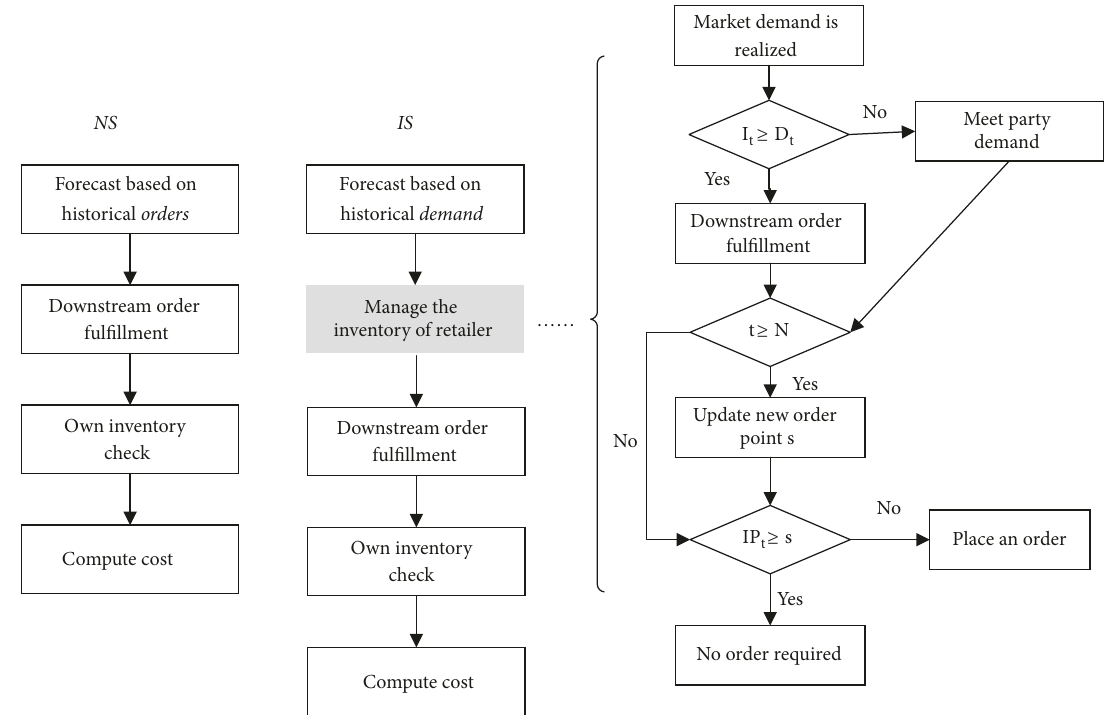
Figure 3: The manufacturer’s behavior under two